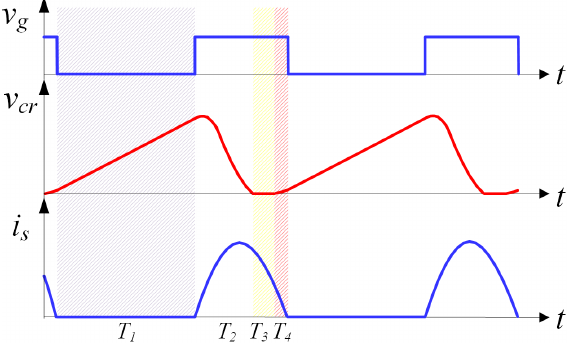
Figure 5. The waveforms of the input side capacitor voltage v cr and insulated gate bipolar transistor (IGBT) current i s